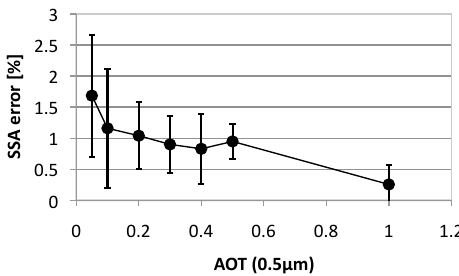
Fig. 4. The absolute value of the averaged error in SSA at a wave- length of 0.5µm on percentage for the value of AOT, 0.05, 0.1, 0.2, 0.3, 0.4, 0.5, and 1.0. The bar indicates the standard deviation. single lens used in the radiometer, which produces an error of ∼ 3 % in the SSA. SKYNET SVA in the standard analysis is calculated by the point source method (Nakajima et al., 1996) by using disk scan data measured at the interval of few days (e.g., 1 week or 10 days) at certain time (e.g, 11:00 a.m. in the morning), and is one month averaged data of SVA of which deviation is within 10 %. However, for some sites, disk scan data are missing for a long time (more than 1 yr). We took standard deviation of the error of determined SVAs at Pune and Beijing, and the standard deviation is within 5–6 %. We therefore put 5 % error in SVA for the test. For the error 3 % in SSA due to SVA error, it was found from the result of the sensitivity test that 5 % error in SVA occurs about 3 % error in